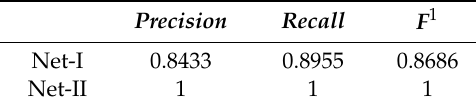
Table 12. Precision, recall and F 1 of Net-I and Net-II.